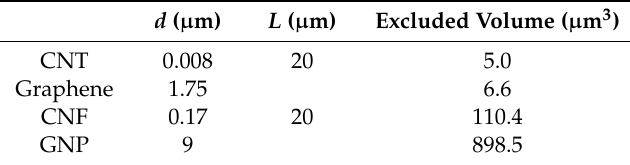
Table 3. Excluded volume calculated with dimensions of carbon